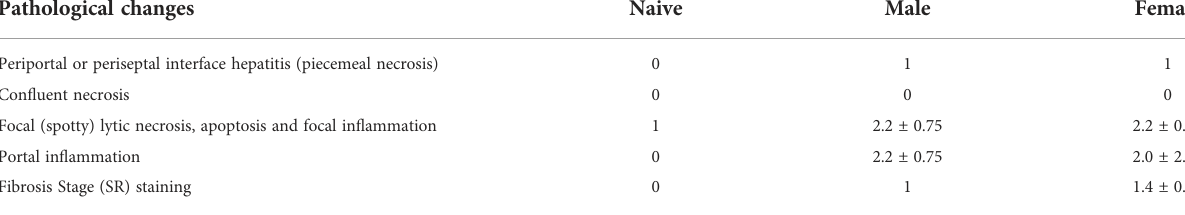
TABLE 1 Histopathological evaluation of liver tissue using a modi fi ed Ishak score. Pathological